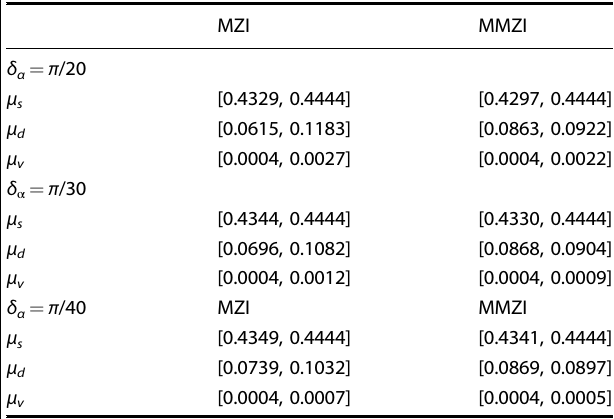
Fig. 7 The secret key rate as the function of communication distance in the scenario that the random intensity fl uctuation is considered. The black-dot line denotes the ideal key rate without any intensity fl uctuation. The red, yellow, and blue lines denote the maximum phase deviation δ α is π /40, π /30, and π /20, respectively. The modulated phase is in the range of [ α − δ α , α + δ α ]. The solid line and dash line denote employing MMZI and MZI,